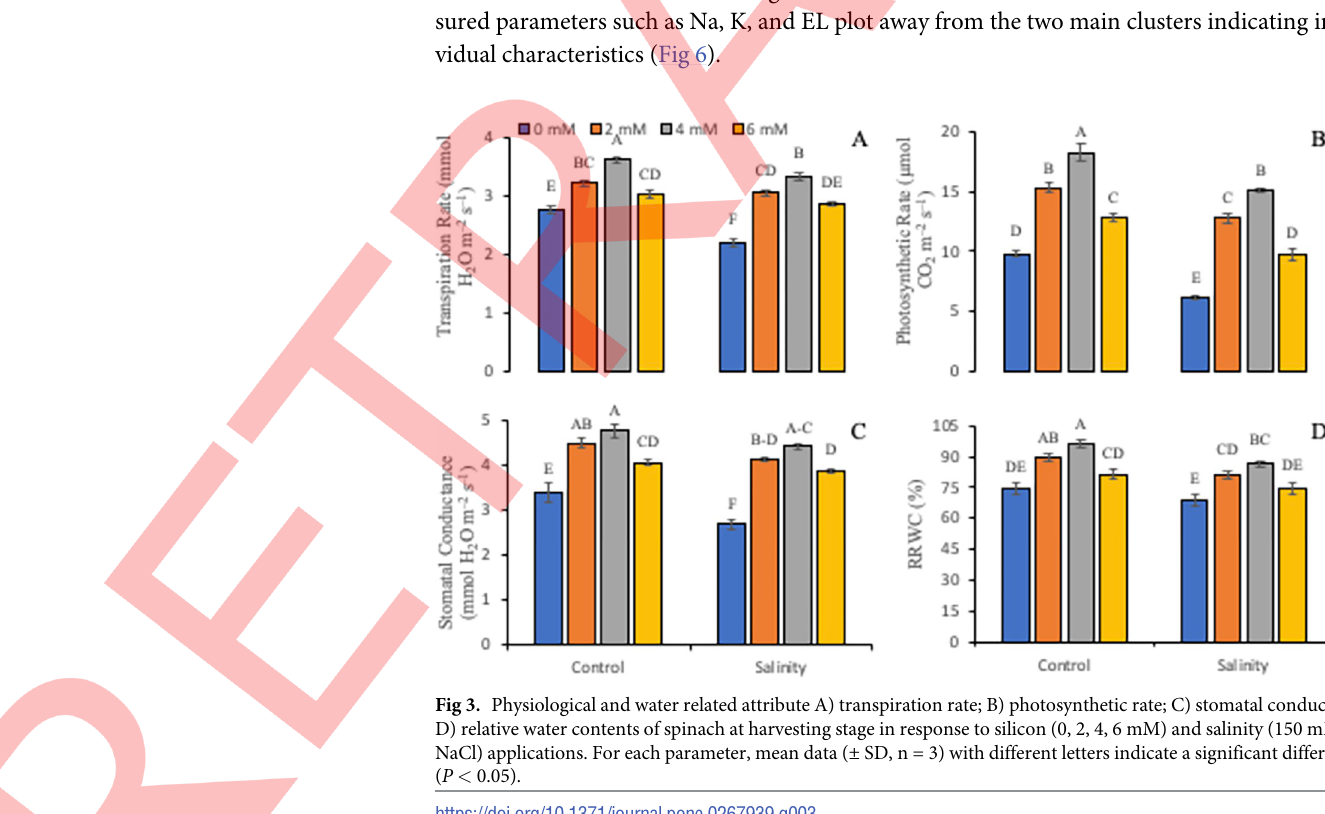
that show some correlation among each other is also located close to the axis line. A few mea- sured parameters such as Na, K, and EL plot away from the two main clusters indicating indi- vidual characteristics (Fig 6).